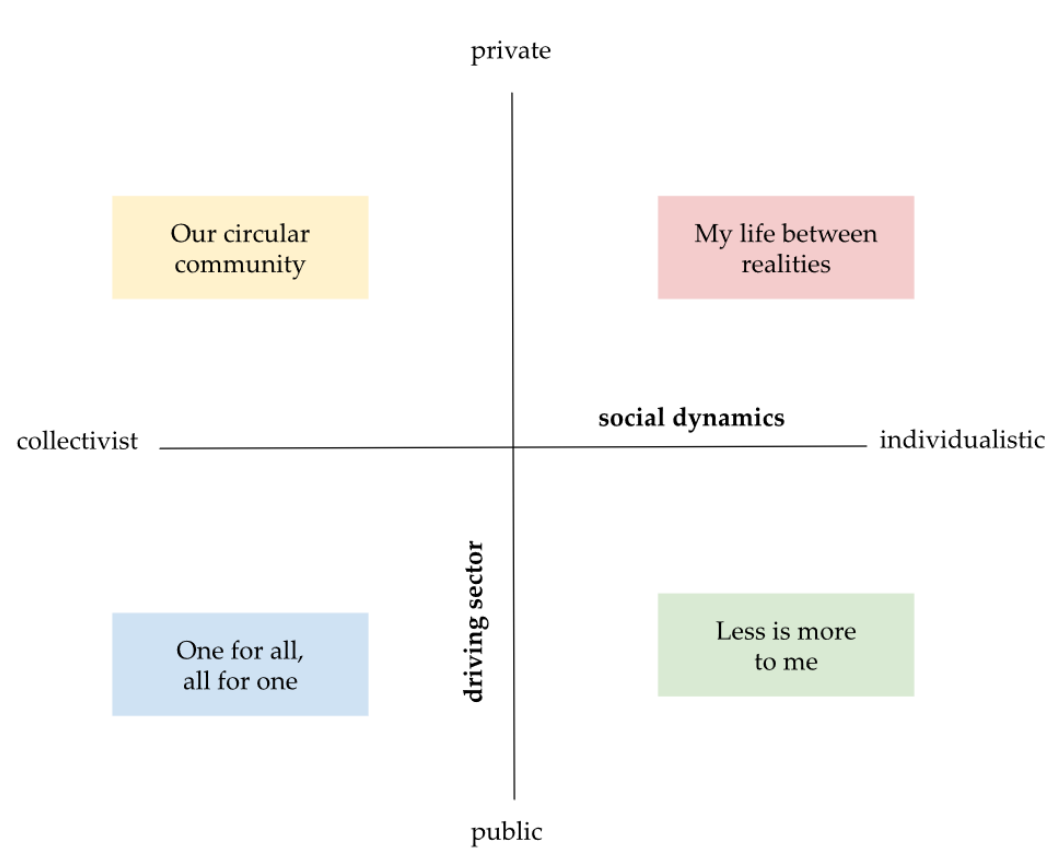
Figure 1. The main characteristics of the four future scenarios (adapted from [14]).